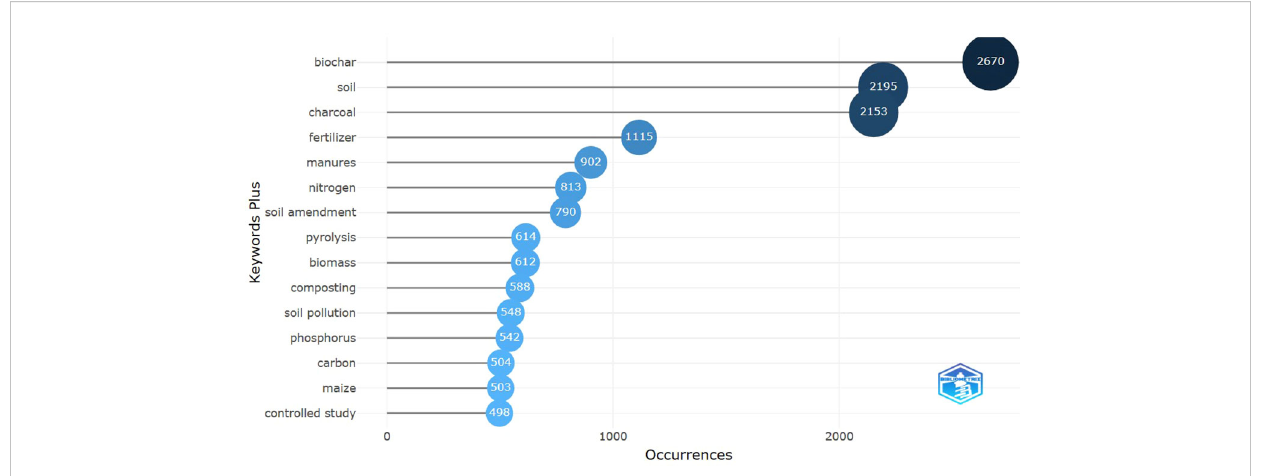
FIGURE 4 Top fi fteen most relevant words on biochar-based smart